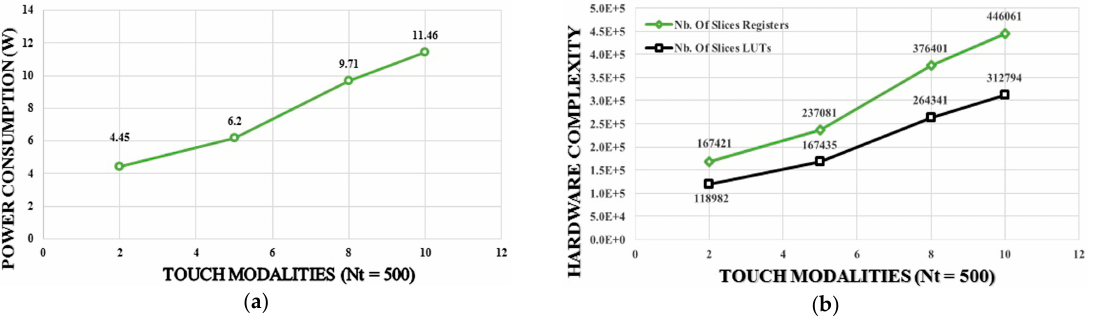
Figure 8. Number of touch modalities versus ( a ) power consumption and ( b ) hardware complexity ( Nt = 500).